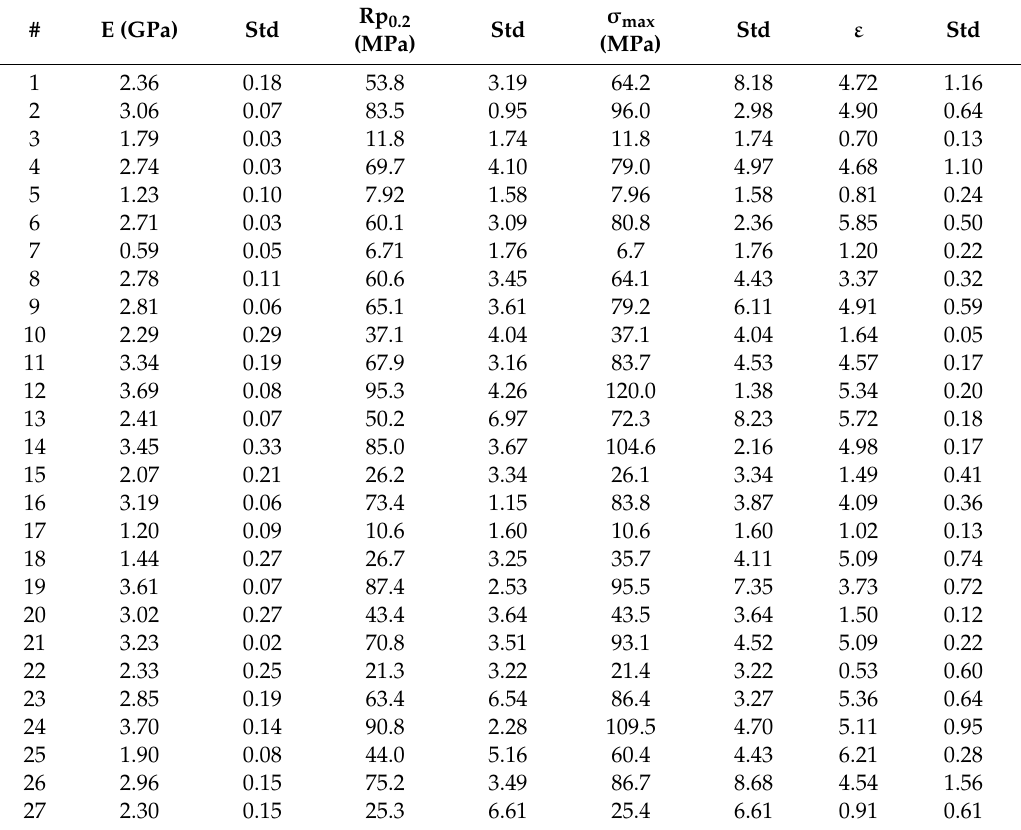
Table 5. Average results and standard deviations of the material properties. E: Young’s modulus, Rp 0.2 : yield strength, σ max : maximum strength, ε : maximum deformation, Std: standard deviation for each